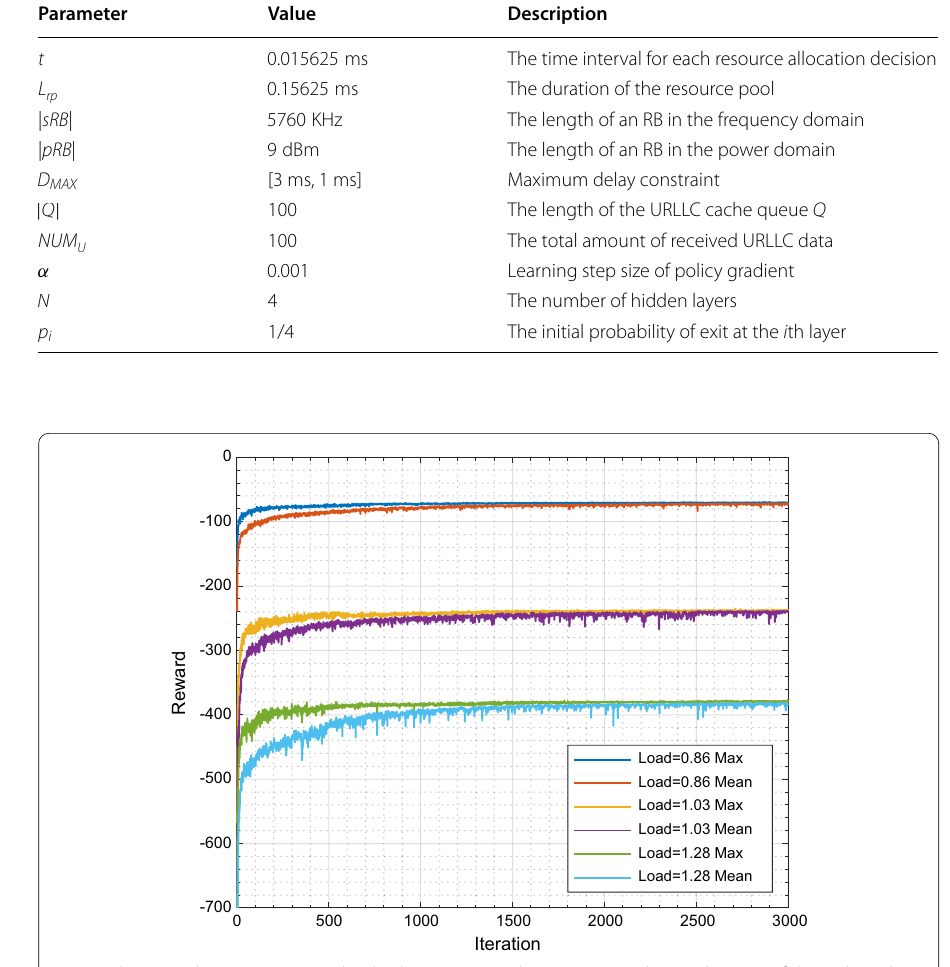
Fig. 6 The reward curves at various loads. The average and maximum total reward curves of the RL-based hybrid spectrum and power resource allocation scheme with loads of 0.86, 1.03, and 1.28. The x -axis is the number of iterative trainings, and the y -axis is the total reward in Eq.